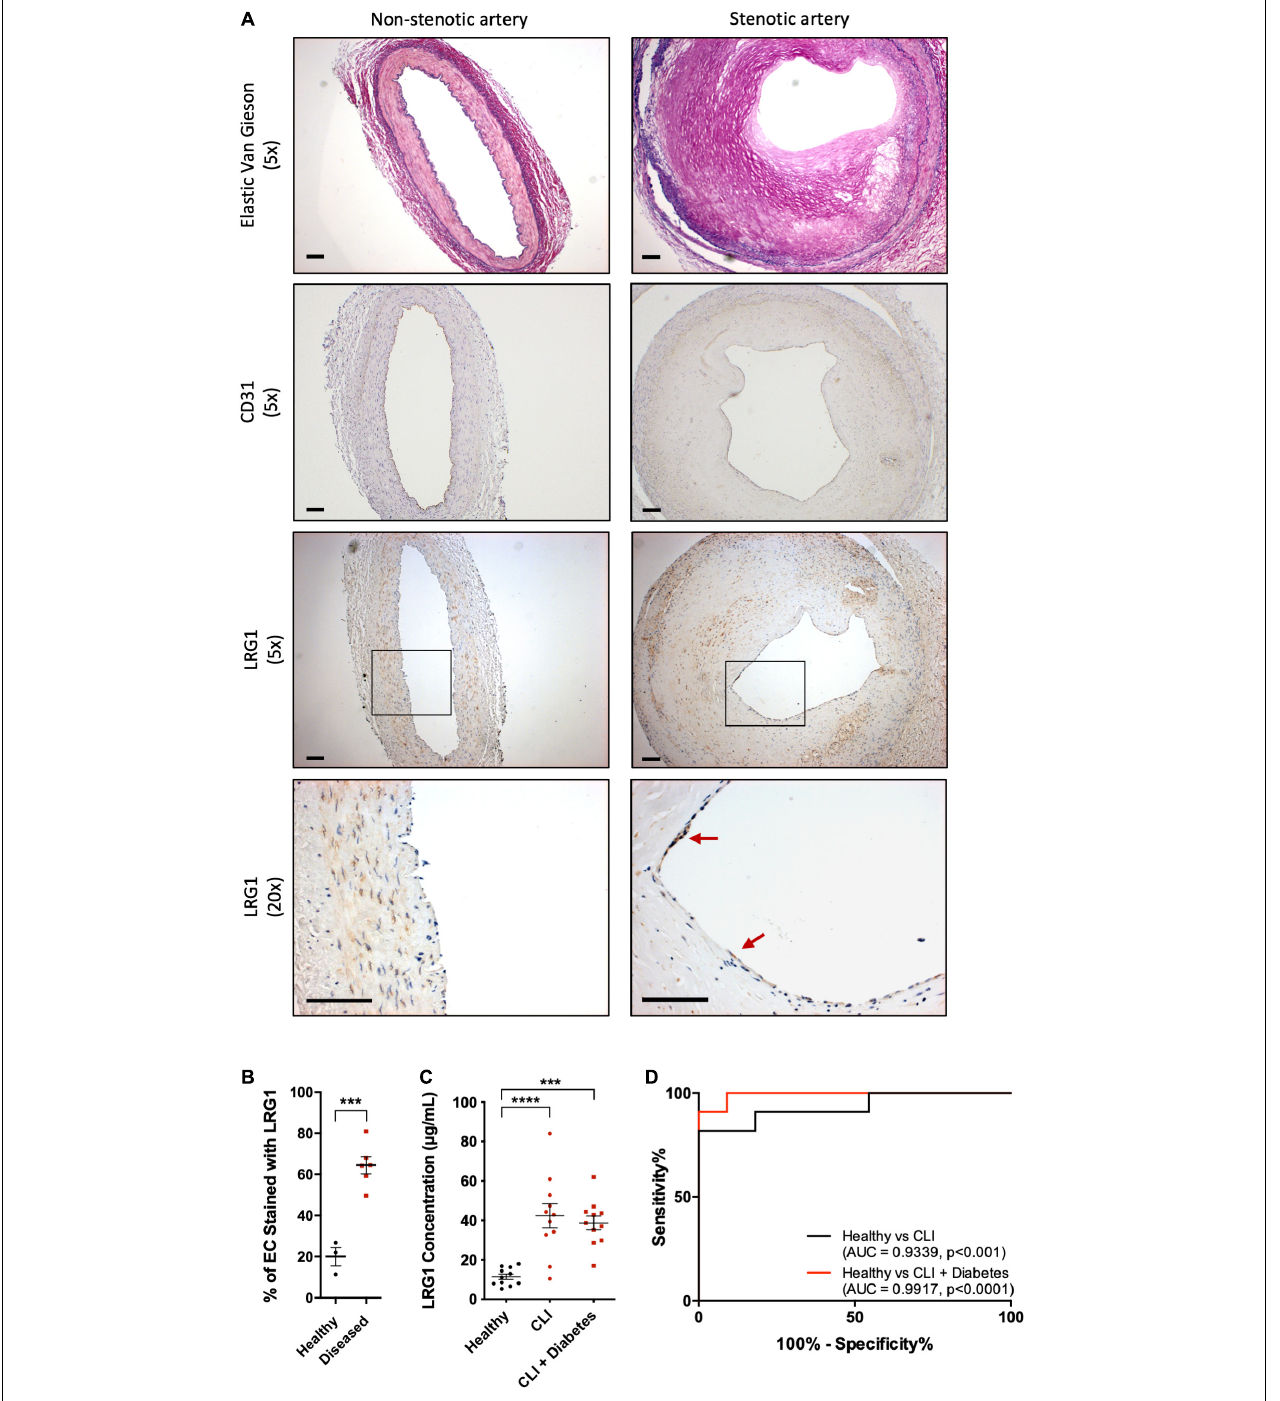
FIGURE 1 | Leucine -rich α -2-glycoprotein (LRG1) was upregulated in patients with vascular disease. (A) Elastic Van Gieson (EVG) (first row) staining and immunohistochemical CD31 (second row) and LRG1 (third and fourth row) in sections of non-stenotic (left column) and stenotic (right column) coronary artery. LRG1 was highly expressed in endothelial cells of stenotic arteries compared to non-stenotic arteries. Red arrowheads show examples of LRG1-expressing endothelial cells. Scale bar = 100 µ m. (B) The percentage of endothelial cells staining for LRG1 was significantly higher in diseased coronary arteries than non-diseased coronary arteries. (C) ELISA measurement of LRG1 concentration in plasma from healthy controls and critical limb ischemia (CLI) patients, with and without diabetes. LRG1 was significantly increased in the serum of CLI patients with and without diabetes. (D) Receiver Operating Characteristic (ROC) curve analysis for the ability of serum LRG1 to differentiate between healthy controls and CLI patients, and between healthy controls and CLI patients with diabetes. [ (B) , Unpaired two-tailed Student’s t -test; n ≥ 3. (C) , One-way ANOVA followed by Bonferroni post hoc test; n = 11/group. *** p < 0.001; **** p < 0.0001].